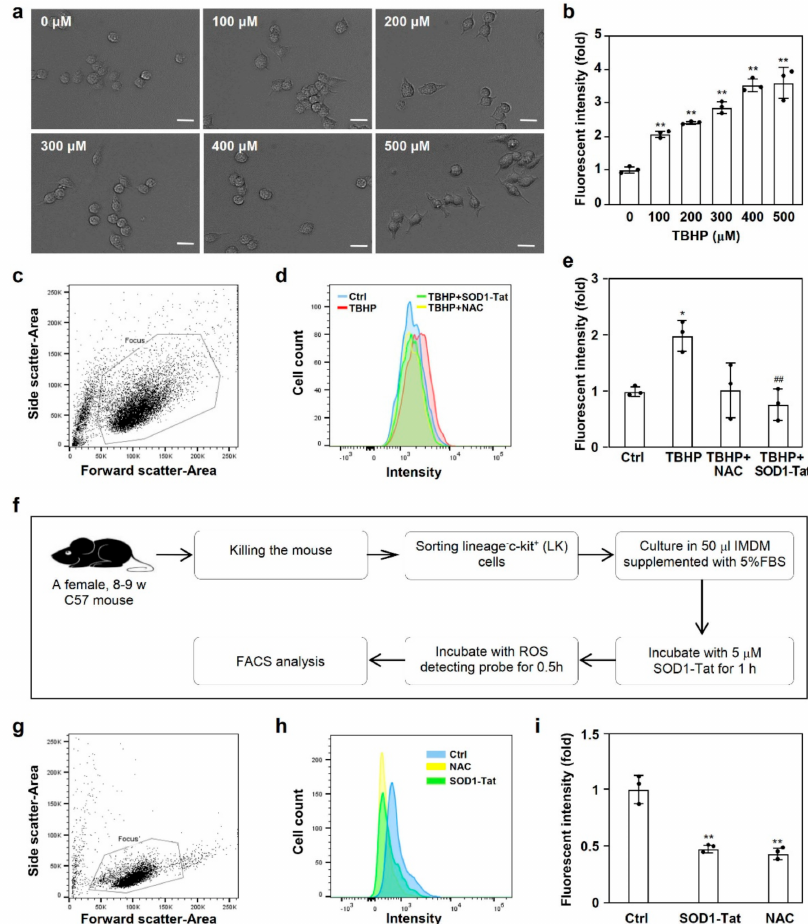
Figure 2. The antioxidant activity of the SOD1-Tat fusion protein. ( a ). Morphology of RAW264.7 cells challenged with tert-butyl hydroperoxide (TBHP) at different concentrations. Bars represent the length of 20 µ M. ( b ). TBHP treatment increased the ROS levels in RAW264.7 cells. RAW264.7 cells were challenged with different concentrations of TBHP. The ROS level was measured by flow cytometry with a DCFHDA probe of the CellROX ® green assay kit. *: p < 0.05; **: p < 0.01, versus the control group. ( c – e ). SOD1-Tat pretreatment restrained ROS production in RAW264.7 cells challenged with TBHP. RAW264.7 cells were pretreated with 5 µ M SOD1-Tat, 1 mM N-acetyl-L-cysteine (NAC), or PBS for 0.5 h. Then, 100 µ M TBHP was added for another 0.5 h. The ROS level was measured by flow cytometry with a DCFHDA probe. The RAW264.7 cell population was selected by gating physical characteristics ( c ). Histogram of the fluorescence intensity of ROS in RAW264.7 cells ( d ). Blue line, control group; red line, TBHP group; green line, TBHP+SOD1-Tat group; yellow line, TBHP+NAC group. ROS production in RAW264.7 cells was quantitated according to the ratio of fluorescence intensity in the experimental versus control groups ( e ). Results are presented as mean ± SD and represent three independent experiments ( n = 3). *, p < 0.05, versus control group; ##, p < 0.01, versus TBHP group. ( f ). Flow chart for the detection of ROS. LK cells were sorted from isolated TBM cells and cultured in 50 µ L IMDM containing 5% FBS. After incubation with 5 µ M SOD1-Tat, 1 mM NAC, or PBS for 1 h, the ROS level was measured by flow cytometry with a DCFHDA probe. ( g – i ). SOD1-Tat treatment decreased ROS production in LK cells. The live cell population was selected by gating physical characteristics ( g ). Histogram of the fluorescence intensity of ROS in LK cells ( h ). Blue line, control group; green line, SOD1-Tat group; yellow line, NAC group. ROS production in LK cells was quantitated according to the ratio of fluorescence intensity in the experimental versus control groups ( i ). Results are presented as mean ± SD, and represent three independent experiments ( n = 3). **, p < 0.01, versus control